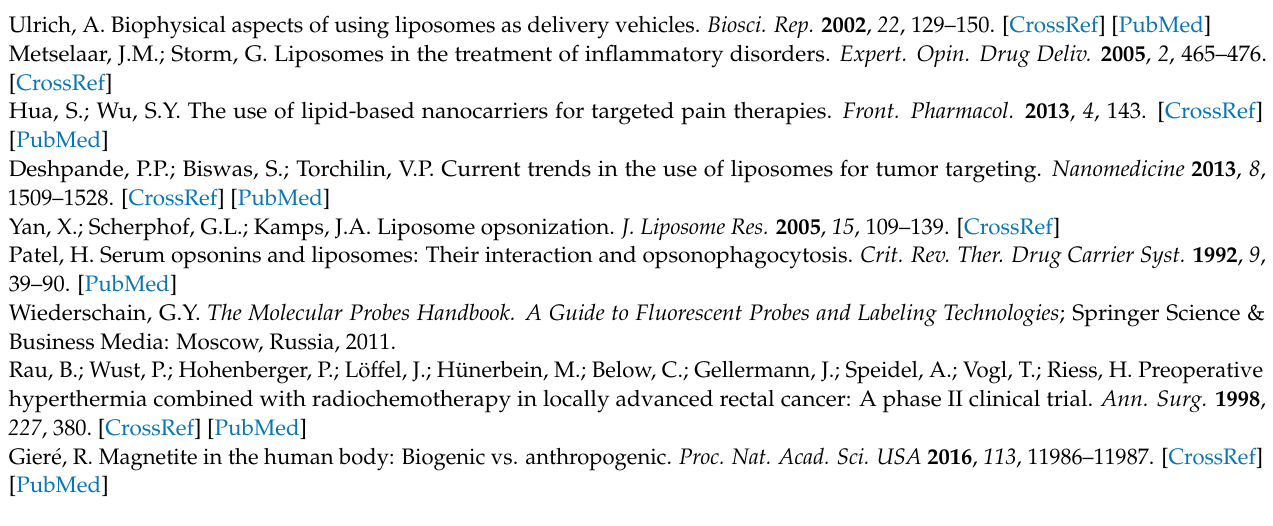
2. TEM image and DLS correlation curves of SMLs: Figure S2: TEM image of solid magnetoliposomes at a lower magnification. Figure S3: DLS correlation curves for solid magnetoliposomes. ( A ): SMLs mathematical modeling of release profile: Table S3: Obtained constant values by the fitting of each mathematical model to the kinetic data and respective coefficient of determination ( R 2 ), according